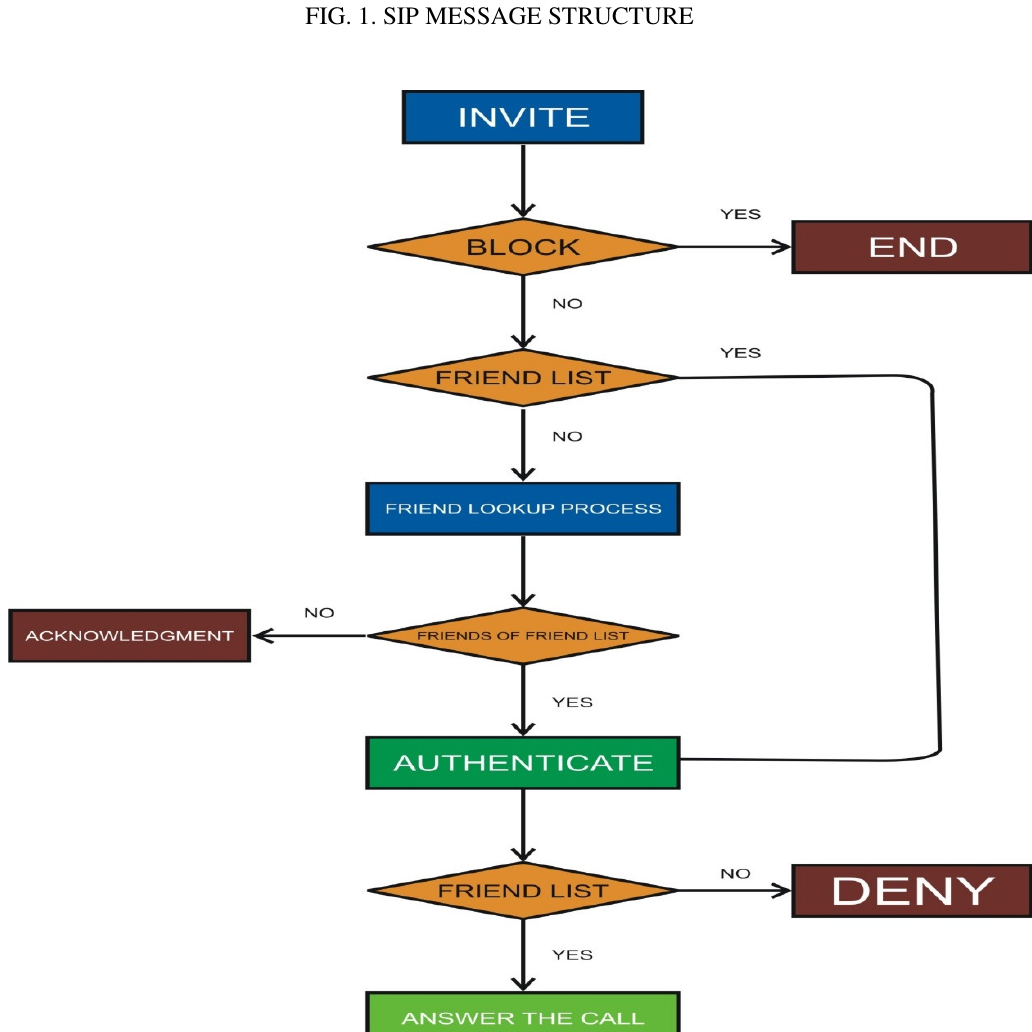
FIG. 2. WORKING PROCEDURE FLOW CHART OF SIP